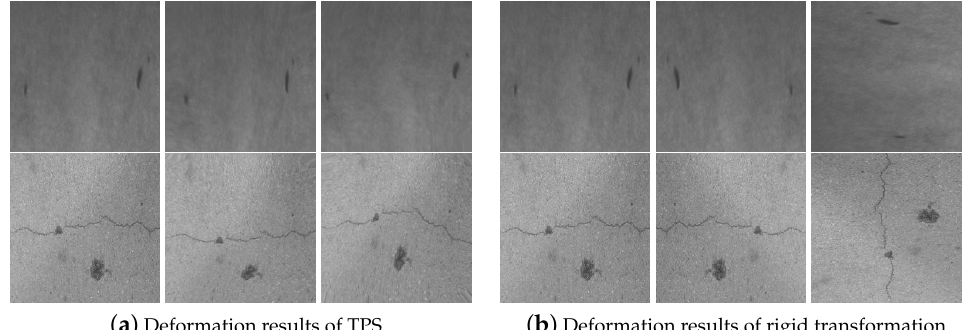
Figure 2. Data augmentation based on TPS ( a ) and rigid transformation ( b ). The leftmost is the original image for each type of surface, others are deformation